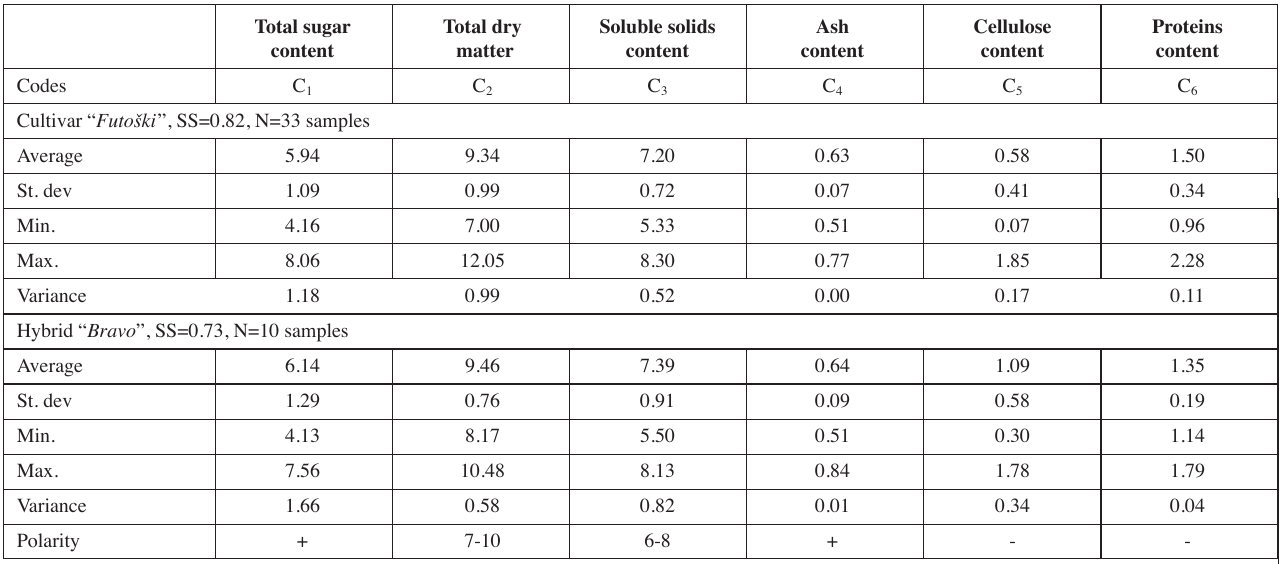
Tab. 1: Chemical characteristics of raw cabbage, cultivar “Futoški“ and hybrid “Bravo” (g/100g).